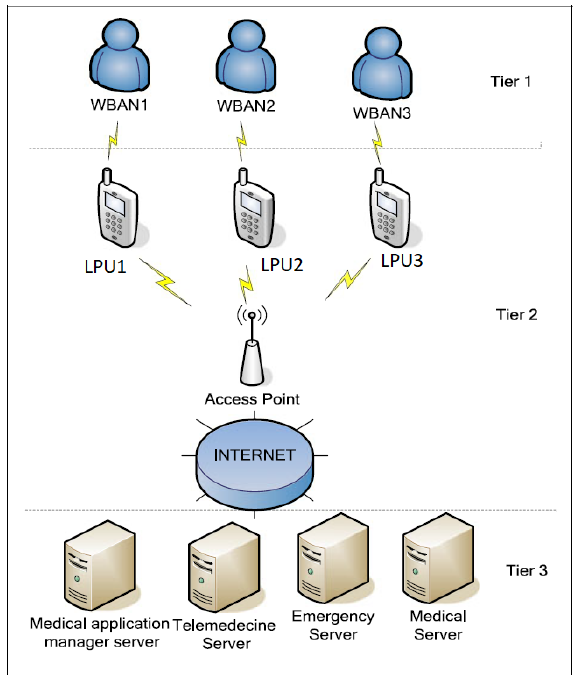
Figure 1. WBAN architecture